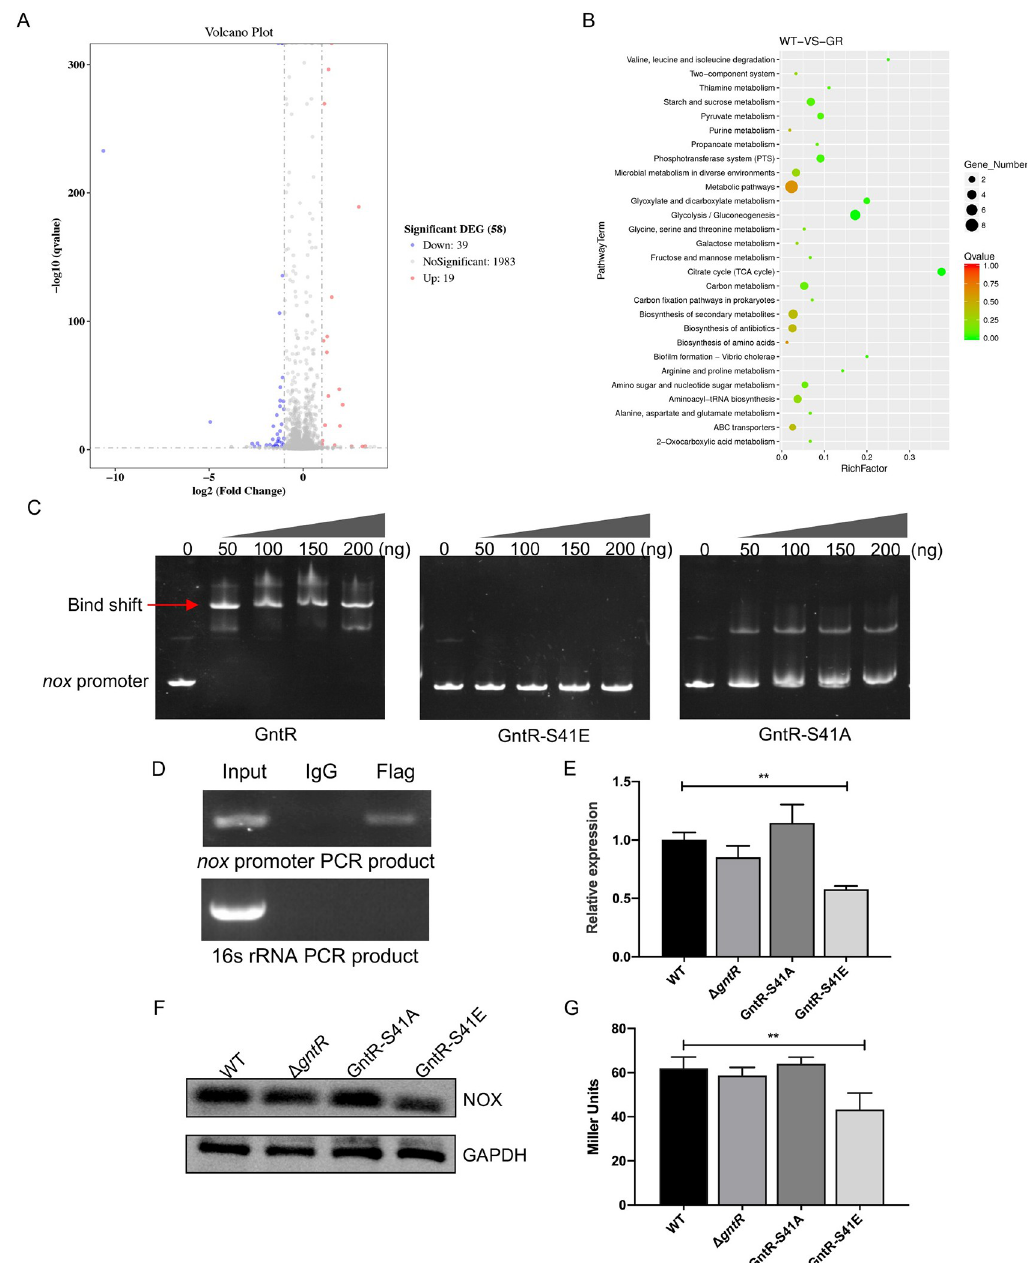
Fig 3. Phosphorylation of GntR inhibits transcription of nox . (A) Volcano plot displaying differential gene expression by RNA-seq in WT SS2 versus Δ gntR . The genes that are significantly up-regulated or down-regulated with at least 2-fold have been highlighted as red and blue dots, respectively. (B) KEGG pathway enrichment scatters diagram of differentially expressed genes. (C) GntR, GntR-S41A, and GntR-S41E proteins were incubated with DNA fragments (80 ng) of ~200 bp length of nox upstream region. The reaction was carried out at 37˚C for 30 min, separated on 6% polyacrylamide gels in 0.5 × TBE buffer, and stained with ethidium bromide for imaging. (D) The binding of GntR on the nox promoter region was detected by ChIP assay. C Δ gntR-flag was grown to the log phase, and after washing with PBS, the DNA was fragmented. The anti-Flag antibody was used to collect the precipitated DNA fragments interacting with GntR, and normal mouse IgG was used as the negative control. Purified DNA was used as a template to amplify the target region of the nox promoter. The PCR product of the 16S rRNA gene was used as a negative control. (E) The gene of nox transcript levels in WT SS2, Δ gntR , GntR-S41A, and GntR-S41E were detected by RT-qPCR. (F) The expression of NOX in WT SS2, Δ gntR , GntR-S41A, and GntR-S41E was detected by Western blot. (G) The pTCV-lacZ reporter plasmid containing the nox promoter sequence was transformed into WT SS2, Δ gntR , GntR-S41A, GntR-S41E strains, and the nox -promoter activity was determined and normalized to internal control β